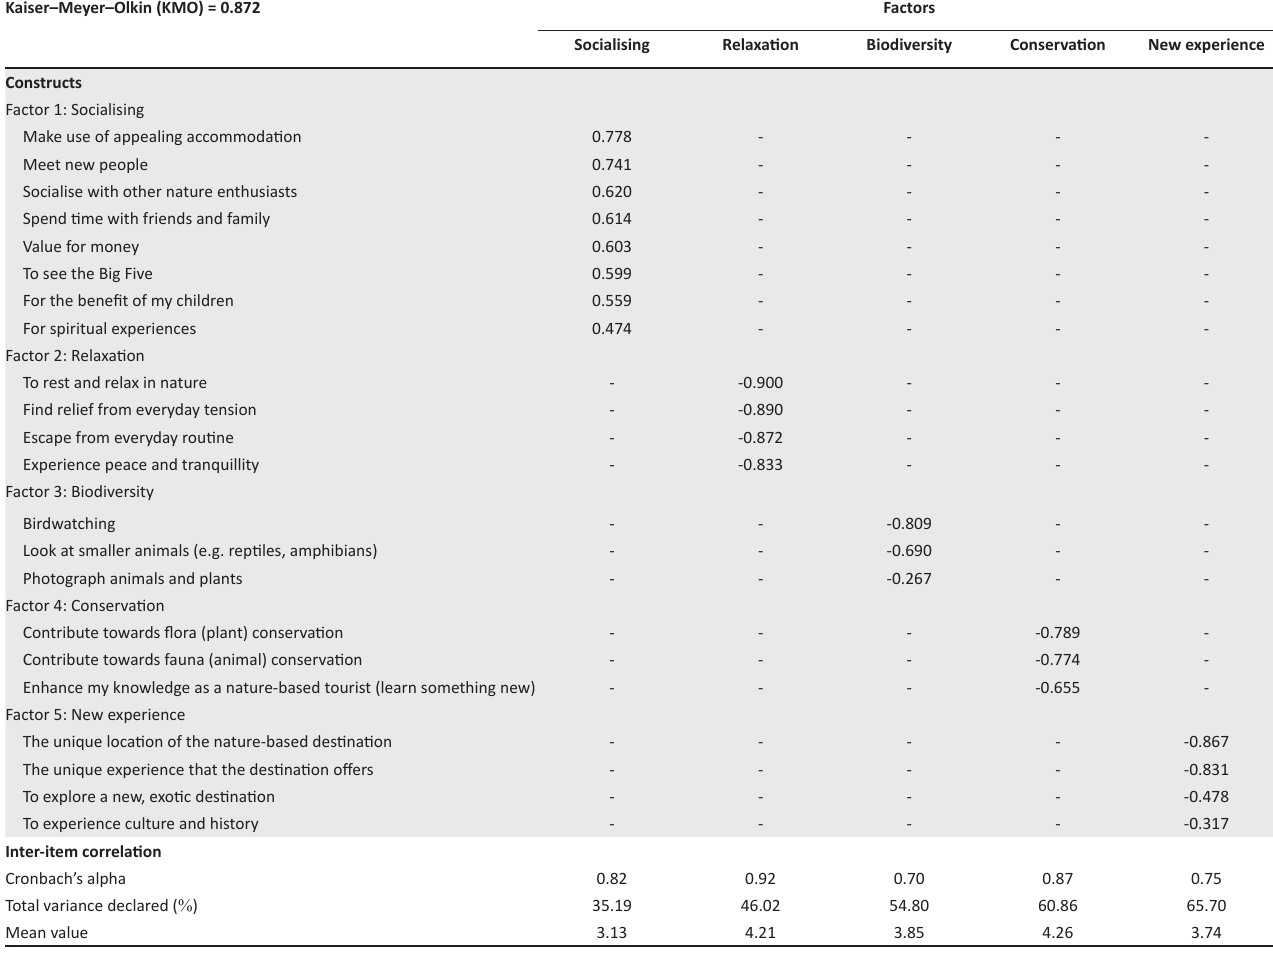
TABLE 3: Pattern matrix and inter-item correlations for travel motives. Kaiser–Meyer–Olkin (KMO) =